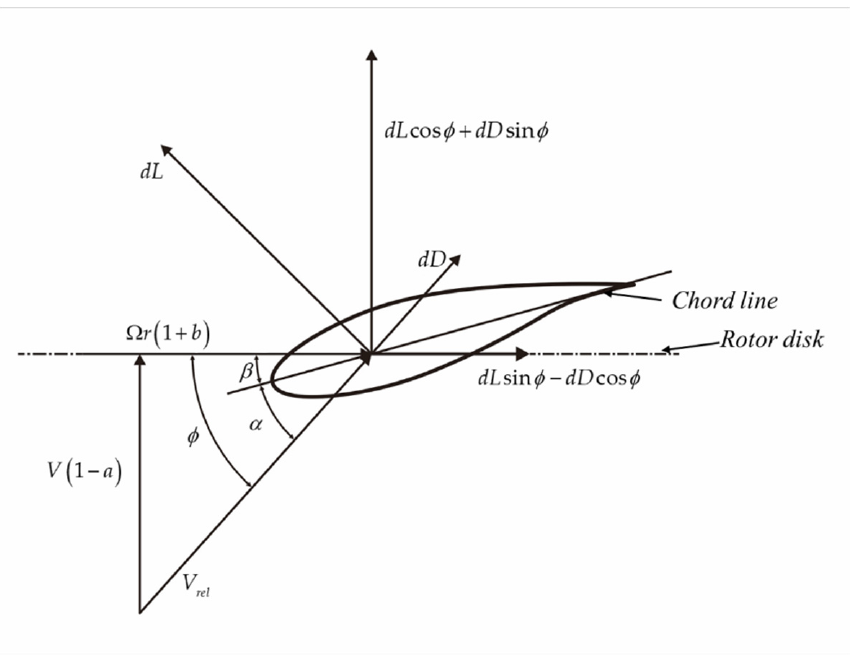
Figure 8. Aerodynamic forces and velocities of an arbitrary blade element. The edgewise moment and flapwise moment of the blade root are obtained by inte- grating the section load in the span direction: